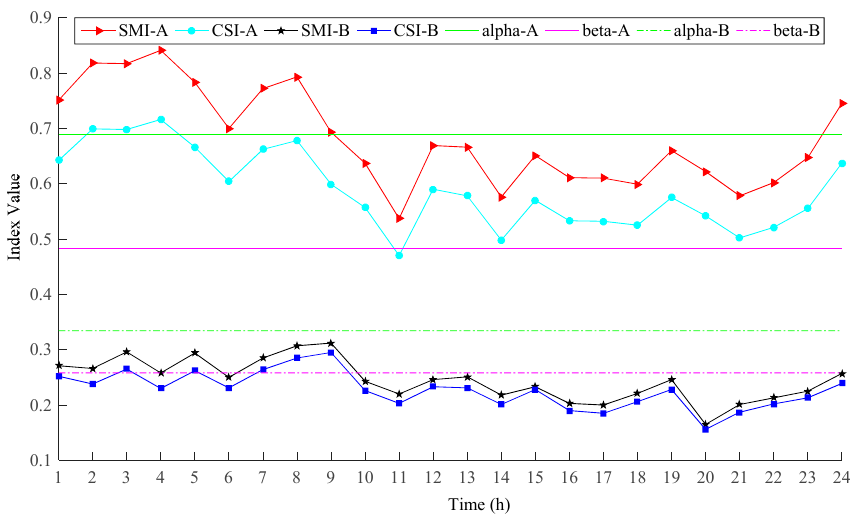
Figure 5. Comparison results for the security levels of two different power systems.